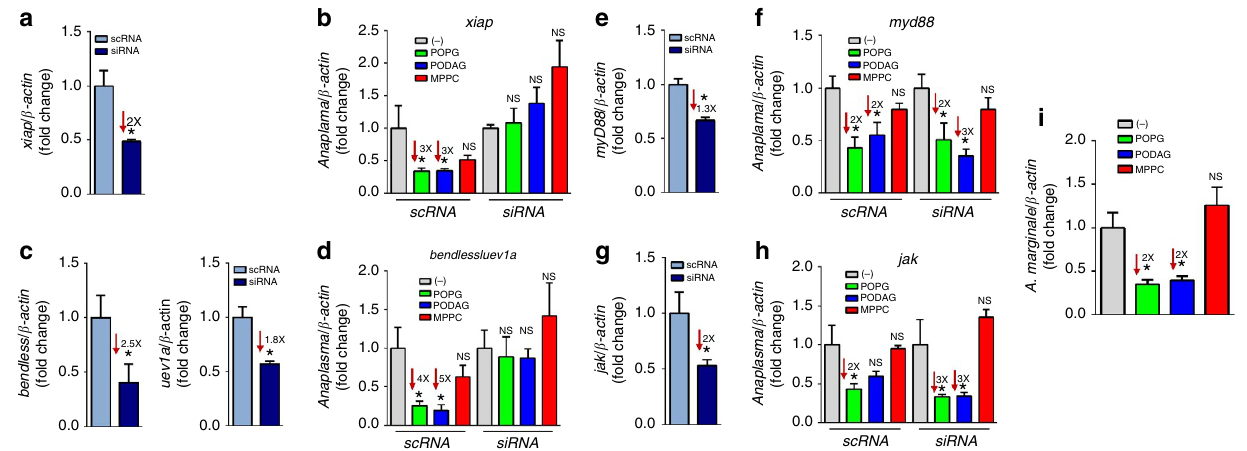
Figure 6 | Lipid priming is protective against bacterial colonization of ticks. ( a–h ) Five replicates of 1 (cid:3) 10 5 ISE6 cells were transfected with siRNA molecules targeting components of the I. scapularis immune system. ( a , c , e , g ) Silencing efficiency or ( b , d , f , h ) A. phagocytophilum load was measured for the components of the ( a – d ) IMD, ( e – f ) Toll and ( g – h ) JAK-STATpathways. Transfected cells were incubated with 1ng of indicated lipids for 6h and infected with A. phagocytophilum at MOI 50. Bacterial burden was quantified and normalized against b - actin . Data are represented as the mean ± standard errors of the means (SEM). Analysis of variance (ANOVA)-Dunnet; Student’s t -test. * P o 0.05. NS, not significant. ( (cid:2) ), non-stimulated. Data are representative of 5 biological replicates and two technical replicates. ( i ) D. andersoni ticks were mock- or lipid-injected (1ng). Ticks were allowed to feed in individual group patches on a splenectomized, acute, A. marginale -infected calf for six days. Midguts from individual ticks were assessed for A. marginale infection levels by quantitative reverse transcriptase–PCR. Bacterial burden was quantified and normalized against b - actin . Samples represent the mean of 15-20